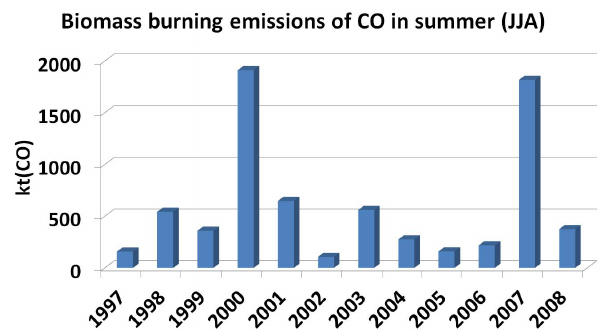
Fig. 4. Biomass burning emissions of CO (kt CO) integrated over the summer period (June, July, August) and over the region marked by the dashed rectangle in Fig. 2, as reported in the GFEDv2 emis- sion inventory (van der Werf et al.,